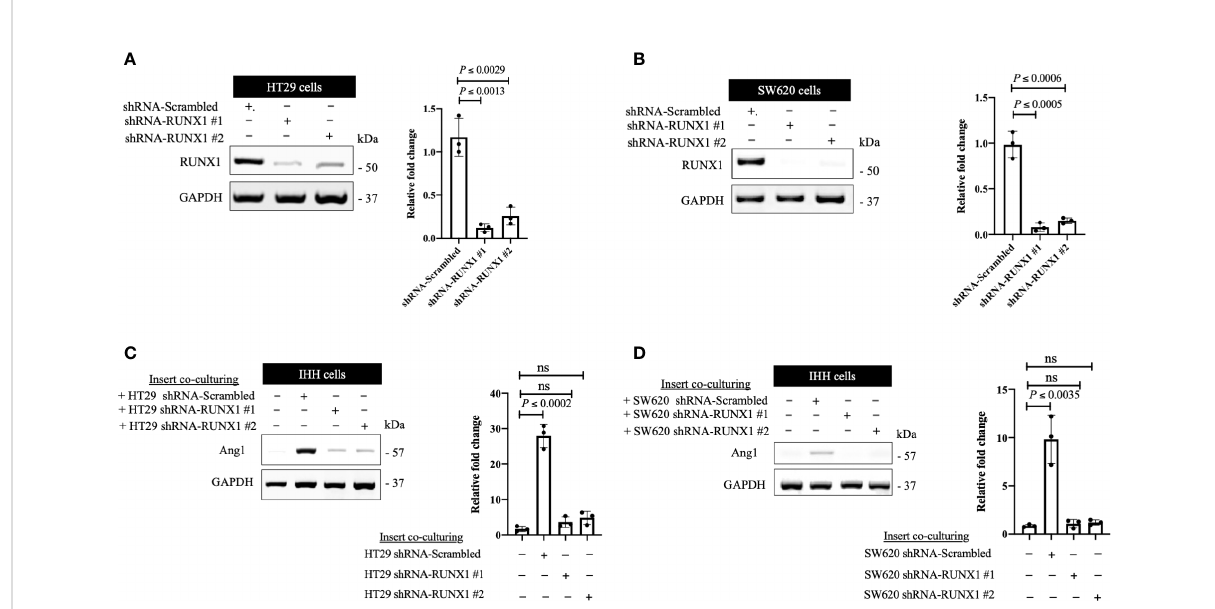
FIGURE 2 The expression of RUNX1 in the cancer cells in fl uences the expression of Ang1 in adjacent hepatocytes in vitro . (A, B) Immunoblotting showing the expression of RUNX1 in colorectal cancer (HT29 and SW620) cells (left panels). The right panels represent the intensity of RUNX1 bands after normalization with GAPDH using ImageJ. Data are from three independent experiments. (C, D) The left panels show the expression of Ang1 in the co-cultured IHH hepatocytes with colorectal cancer (HT29 and SW620) cells. The right panels show the intensity of Ang1 bands after normalization with GAPDH using ImageJ. Data are from three independent experiments. Data are presented as the mean ± SD. ns, Not signi fi